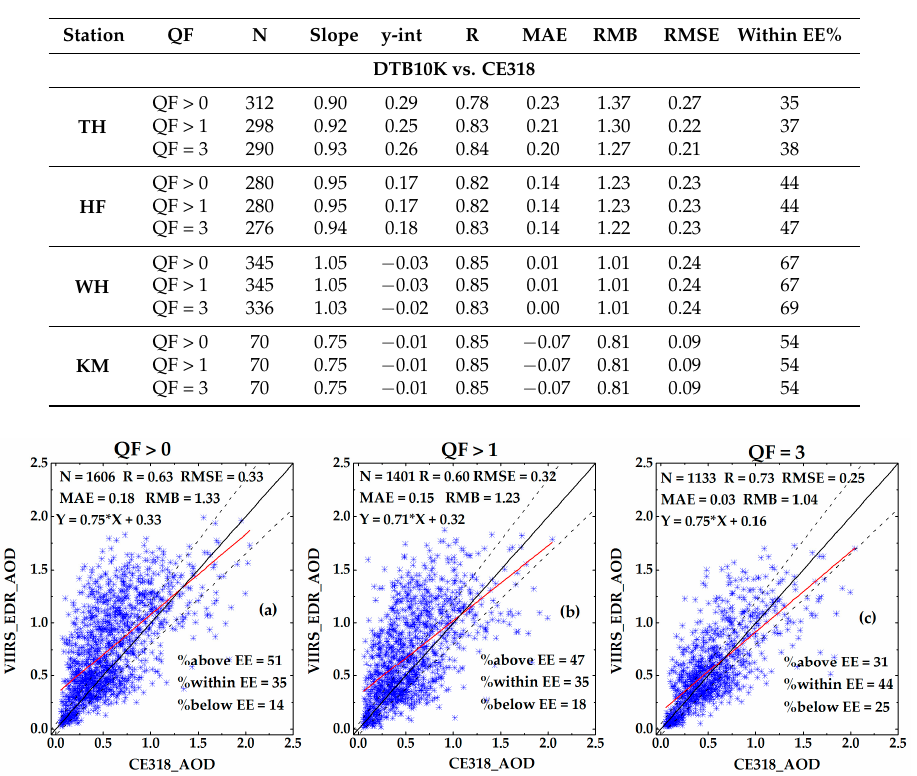
Table 6. As in Table 3, but comparison of the DTB10K AOD products.